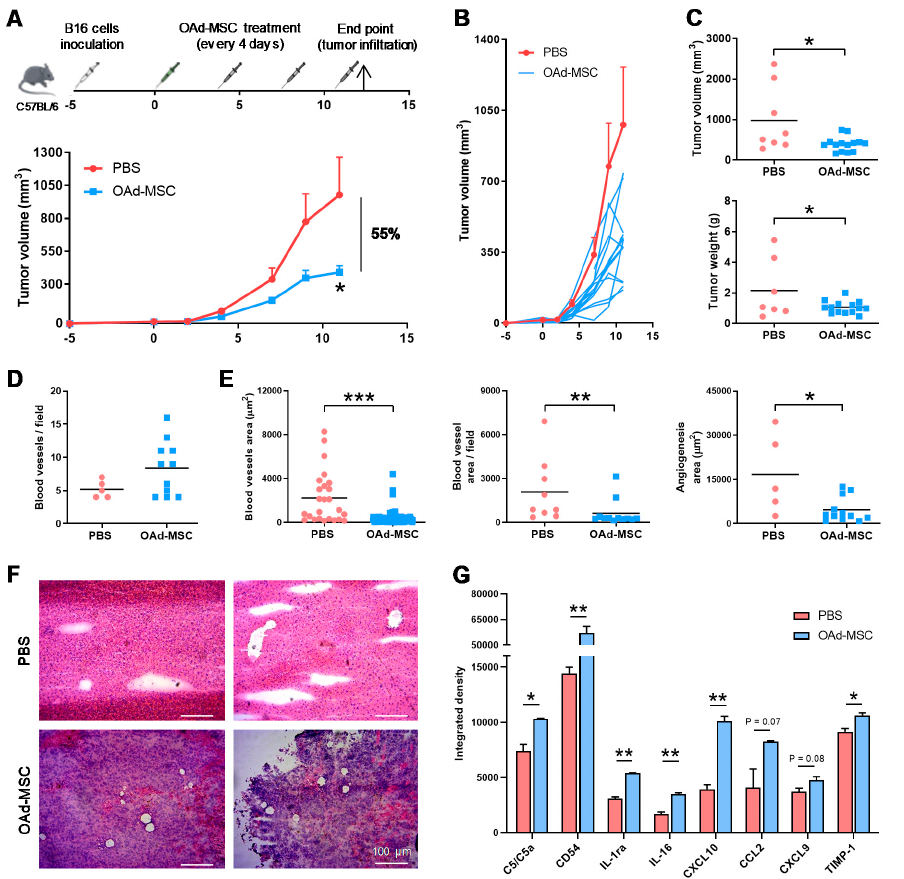
Figure 5. In vivo antitumor e ffi cacy of OAd-MSCs in a mouse model of melanoma. ( A ) Graph represents the experimental design and antitumor e ff ect of OAd-MSCs in C57BL / 6 mice bearing subcutaneous B16 tumors. Lines represent the mean + SEM of the tumor volume in groups treated with PBS (red; n = 8) and OAd-MSC (blue; n = 14) (Mann–Whitney U test). ( B ) Follow-up of tumor volume in mice treated with OAd-MSCs (individual values, blue lines) and control group (mean + SEM, red line). ( C ) Tumor volume and weight of groups treated with PBS and OAd-MSCs at the end points (Mann–Whitney U test and unpaired t -test, respectively). ( D , E ) Angiogenesis was studied by ( D ) quantification of the number of tumor blood vessels per field, ( E ) area per blood vessel, blood vessel area per field, and total angiogenesis area ( µ m 2 ) (Mann–Whitney U test). ( F ) Representative images of hematoxylin and eosin-stained sections from control and treated tumors. ( G ) Quantification by integrated density of pro-inflammatory cytokines di ff erentially expressed in the tumors treated with PBS (red) and OAd-MSCs (blue) (unpaired t -test). * p ≤ 0.05, ** p < 0.01, *** p <